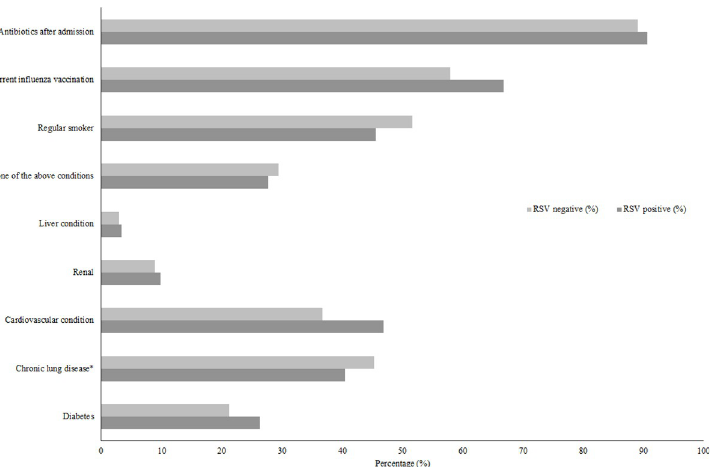
Fig 3. Risk factors among acute respiratory infection (ARI) hospitalizations in adults aged 18 years or more in Auckland, New Zealand, 2012–2015 by respiratory syncytial virus (RSV) result. Among 3,421 patients with complete information on comorbidities, influenza vaccination status, and antibiotic treatment. There was no significant difference in risk factors by RSV positivity status after adjusting for age and ethnicity. � Includes asthma, COPD, and